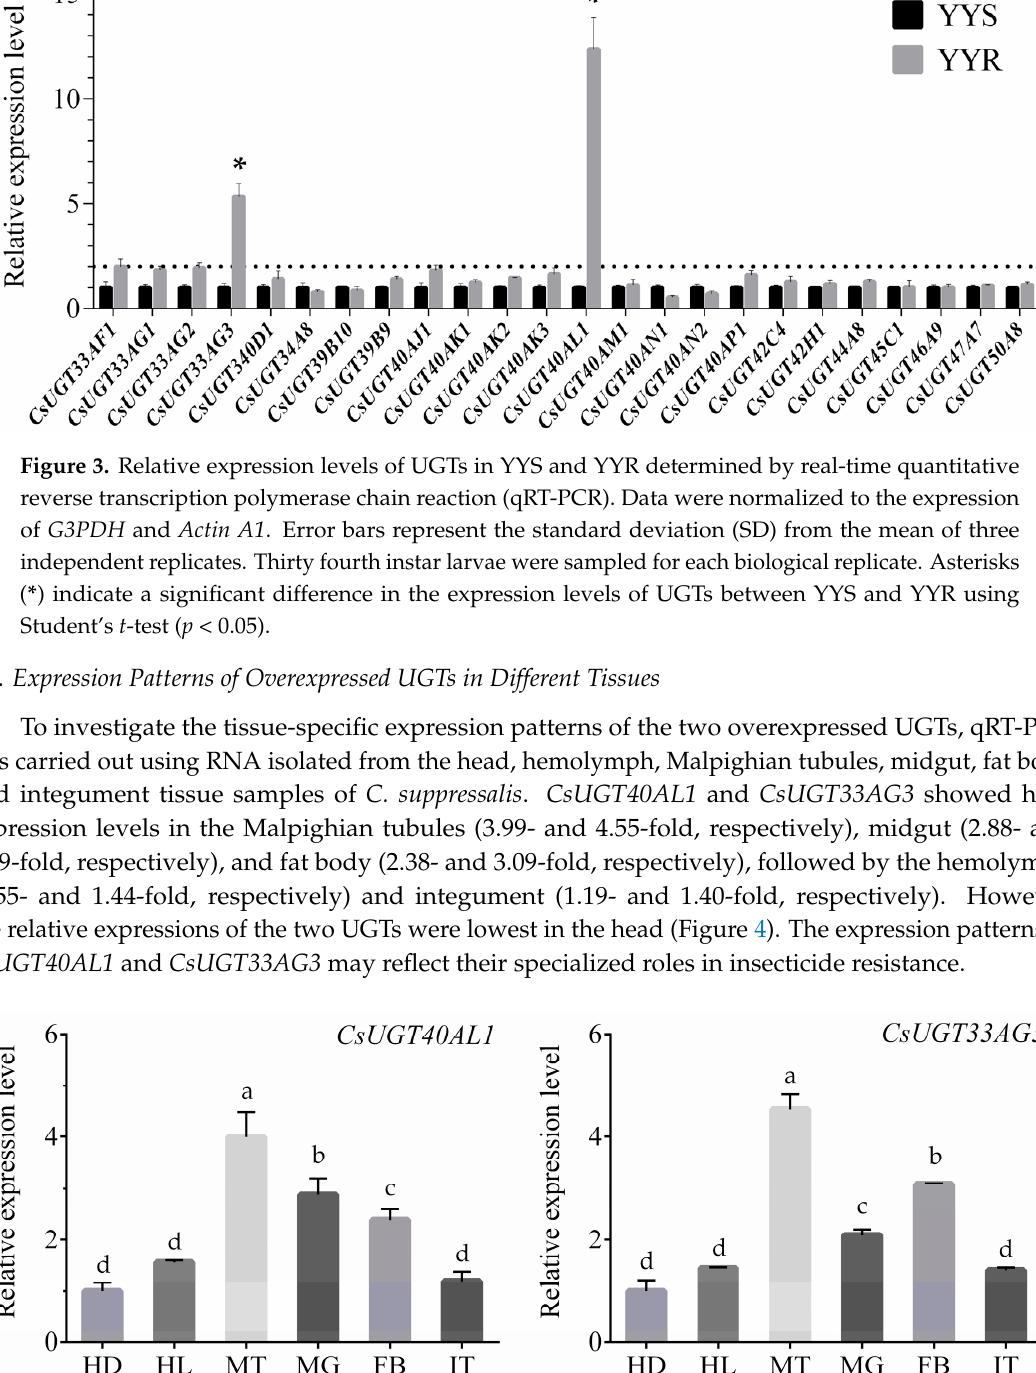
Figure 4. Expressions of CsUGT40AL1 and CsUGT33AG3 in different tissues of the fourth instar larvae of YYS. HD, head; HL, hemolymph; MT, Malpighian tubules; MG, midgut; FB, fat body; and IT, integument. The mRNA levels in the different tissues were normalized to the expressions in the head. Error bars represent the SD from the mean of three independent replicates. For each biological replicate, 30 fourth instar larvae were sampled. Different lowercase letters indicate significant differences among treatments as determined by one-way analysis of variance (ANOVA) followed by Tukey’s honest significant difference (Tukey’s HSD) test ( p <